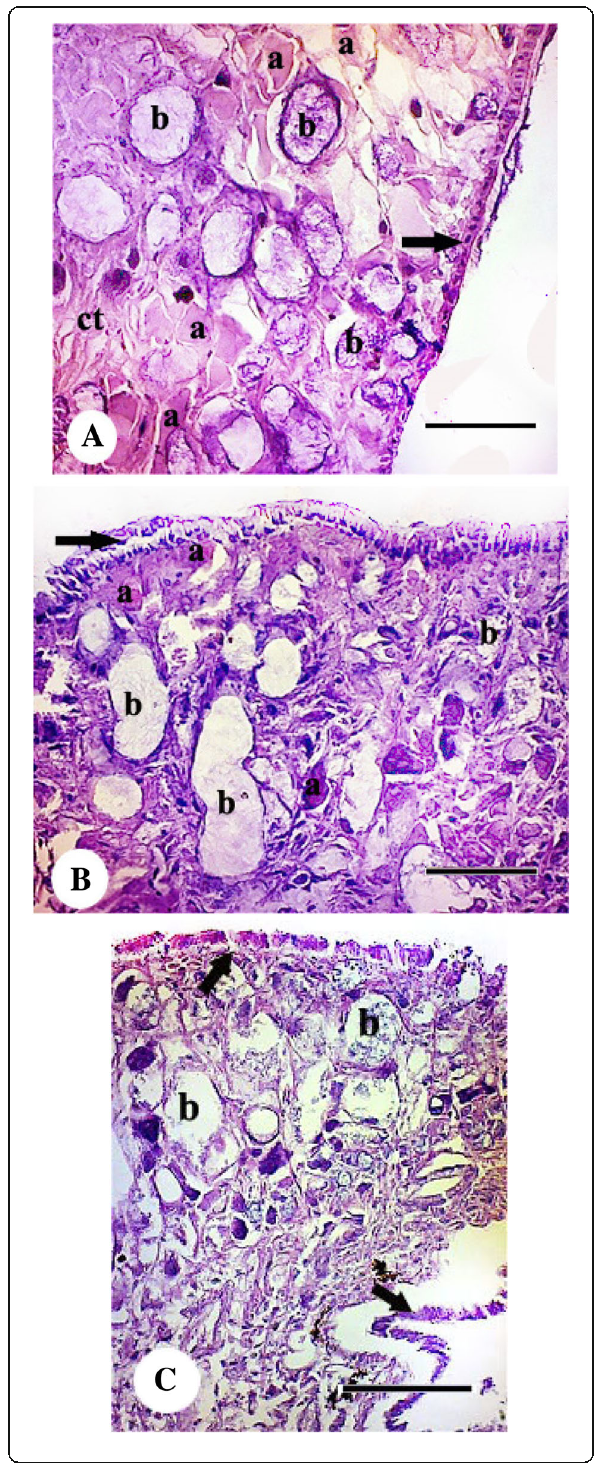
Fig. 1 A Photomicrograph of the mantle edge of unexposed snails showing single epithelial layer (arrow), unicellular glands with acidophilic secretory materials (a), unicellular glands with basophilic secretory materials (b), and connective tissue (ct). B Photomicrograph of the mantle edge of snails exposed to UV-A radiation for 3 h for two successive days showing separation of the epithelial layer (arrow), unicellular glands with acidophilic secretory material (a), and the unicellular glands that have basophilic secretory material increased in size and number (b). C Photomicrograph of snails exposed to UV-A radiation for 3 h for three successive days showing ruptured epithelial layer with disintegrated cells (arrows) and glands with basophilic secretory materials